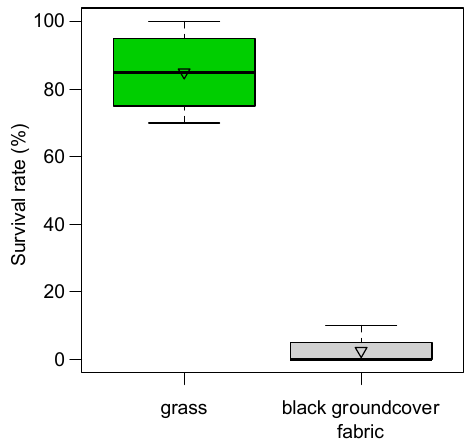
Figure 8. Survival rate of immature stages inside blackberry severed buds deployed on grass ( n = 4) or on black polypropylene woven groundcover fabric ( n = 4). The boxes enclose the first and third quartiles; the ends of the whiskers represent the 5th/95th percentiles, the solid lines the median and the triangle the mean.